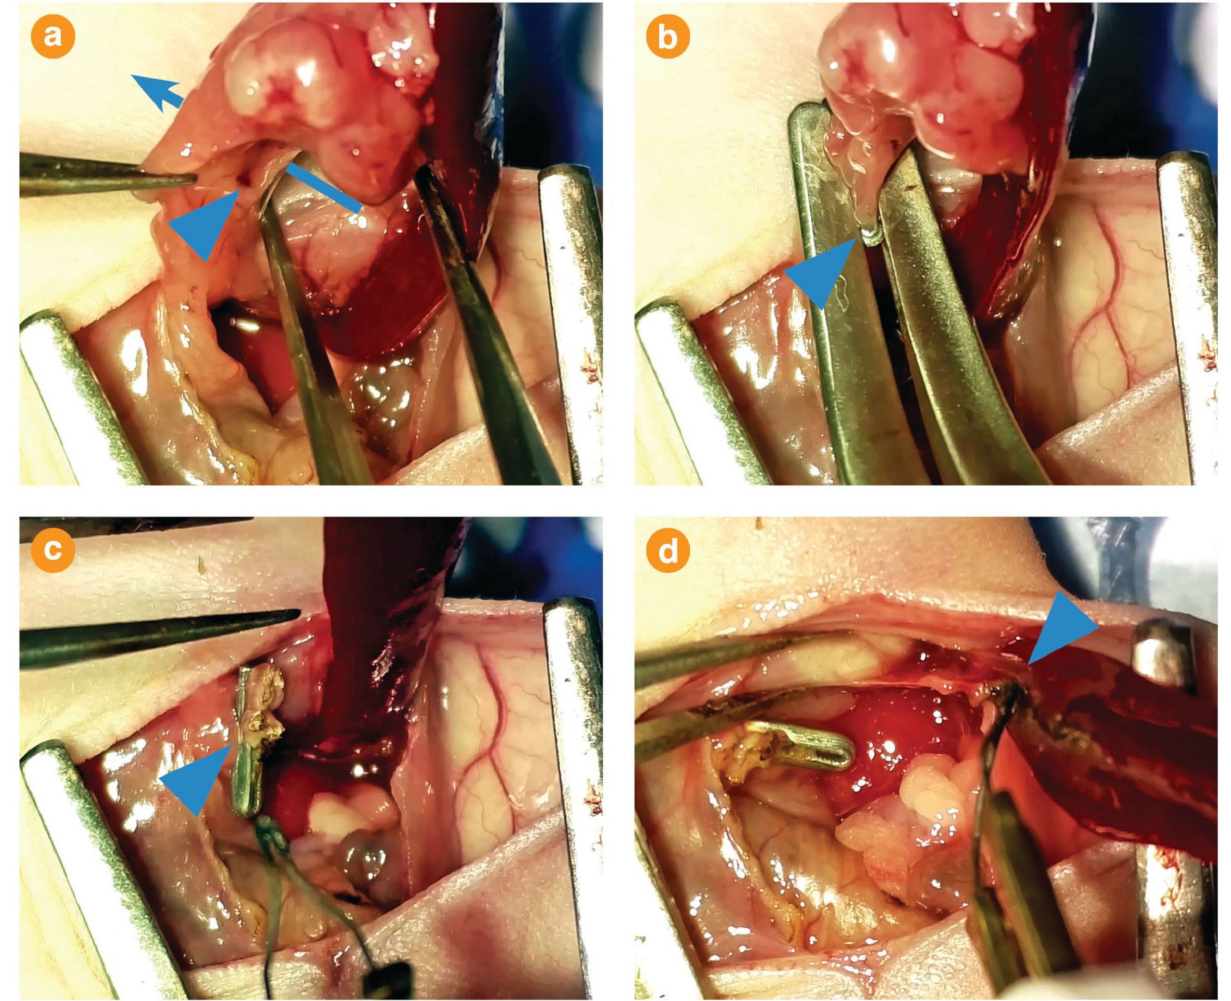
Figure A3. Distal pancreatectomy and splenectomy. These photographs were taken during the procedure and illustrates the key steps. ( a ) A “window” dorsal to body of the pancreas is dissected bluntly (Arrow: passes through the window. Arrowhead: lienopancreatic vein). ( b ) A titanium ligation clip (arrowhead) is applied on the pancreatic body proximal to the tumour. ( c ) The pancreas is transected with cautery (arrowhead: cauterised cut-surface of the pancreas, with adjacent titanium ligation clip). ( d ) Lienogastric vessels (arrowhead) is cauterised at the cranial pole of the